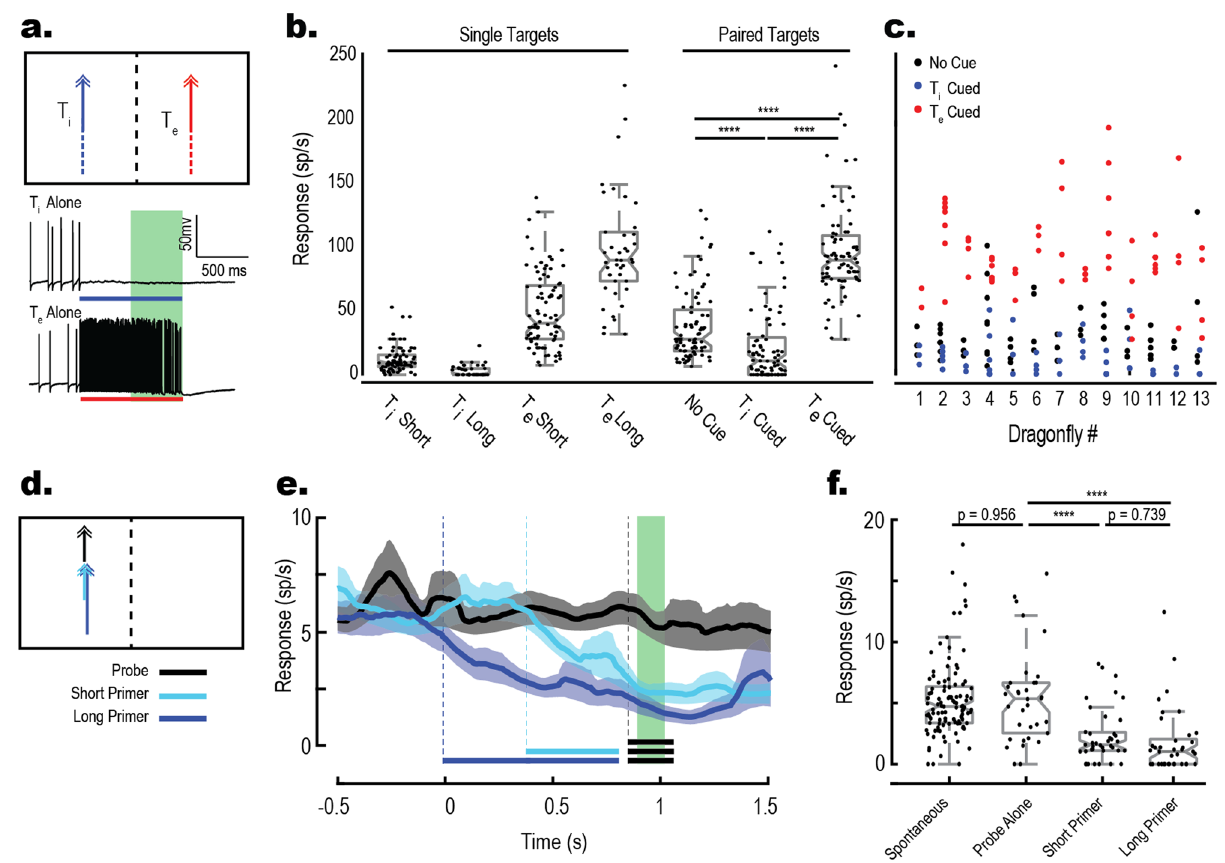
Fig. 4 Target selection and facilitation in the inhibitory receptive fi eld. a Targets vertically ascend a display within CSTMD1 ’ s excitatory or inhibitory receptive fi eld, either individually or as a simultaneous pair. Targets are separated by 50° to avoid the 10° wide region of binocular overlap. Target trajectories can be Short, Long or used as Cues, illustrated with dashed lines. Example traces illustrate CSTMD1 responses to T i and T e . T i generates inhibition, T e generates excitation. b Boxplots with overlaid swarm plots illustrating the mean neuronal response over a 500 ms window (green shaded region in A). Total 480 trials across 13 dragon fl ies. In Paired Target conditions, neuronal responses are broadly distributed, with some trials exhibiting inhibition and others exhibiting excitation ( p < 0.001). Compared to the Paired condition, a preceding T i Cue shifts responses towards inhibition ( p = 0.001) and a T e Cue towards excitation ( p = 0.008). c Responses in each of the 13 neurons to simultaneous paired target trials (black), T i Cued trials (blue) and T e Cued trials (red). The majority of neurons show inhibitory responses to Paired Target trials without cueing, however each neuron is able to respond to either the excitatory or inhibitory target with the appropriate Cue. d Stimulus pictograms illustrating three conditions; Probe Alone (Black line only), Probe preceded by a short Primer (Black and Cyan line), and Probe preceded by a long Primer (Black and Blue). Trajectories are illustrative as they overlie in experiments. e Averaged response across all trials (shaded region is standard error, 110 trials across 11 dragon fl ies) reveals the time course of inhibition. Presentation of a target within the inhibitory receptive fi eld drives neural activity below spontaneous rates ( − 0.5 to 0 s). f Boxplots with overlaid swarm plots show that Probe response is reduced when paired with either a Short (400 ms) or Long (800 ms) primer. Spontaneous spike rate is also illustrated and was measured over an equivalent time period before the beginning of each trial. Statistical testing via Wilcoxon rank-sum